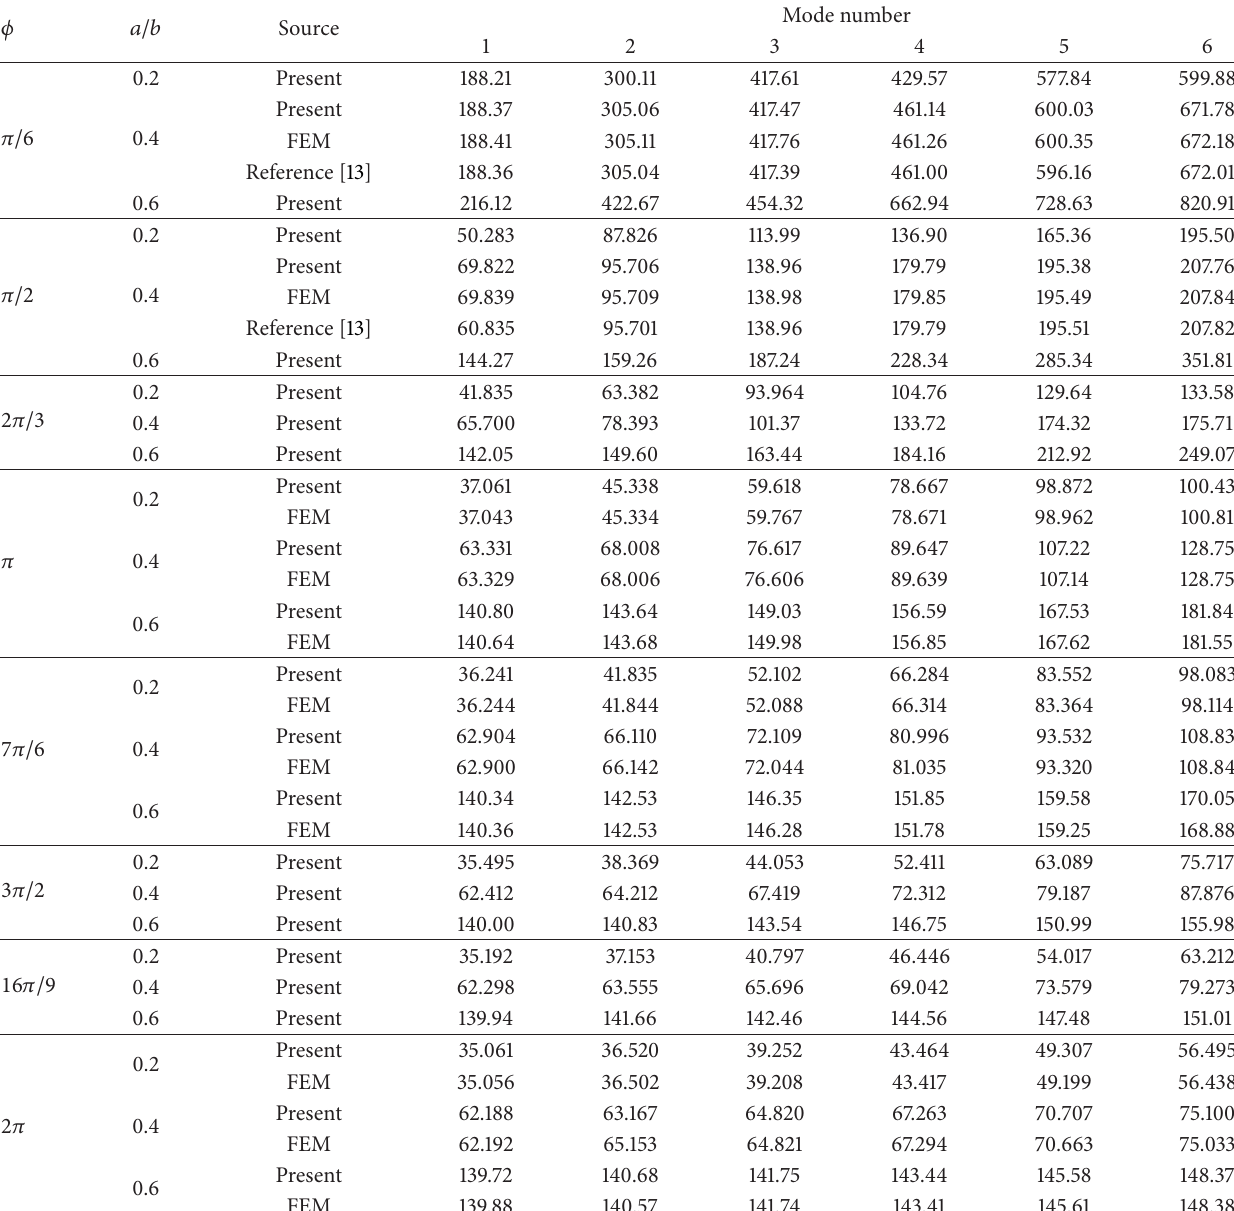
Table 4: Frequency parameters, Ω = 𝜔𝑏 2 (𝜌ℎ/𝐷) 1/2 , for fully clamped annular sector plates ( 𝜇 = 0.3